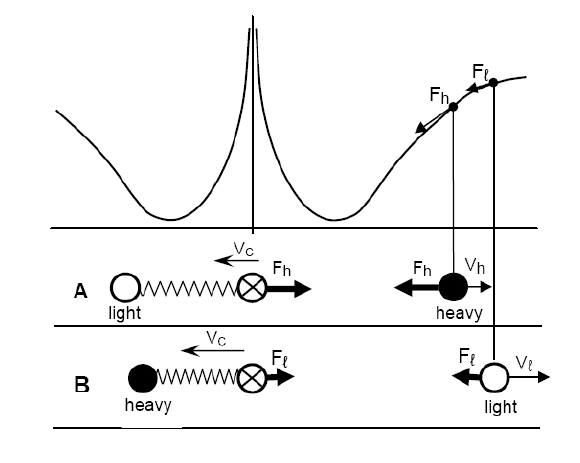
Fig. 16 Schematic representation of heavy (A) and light (B) atom